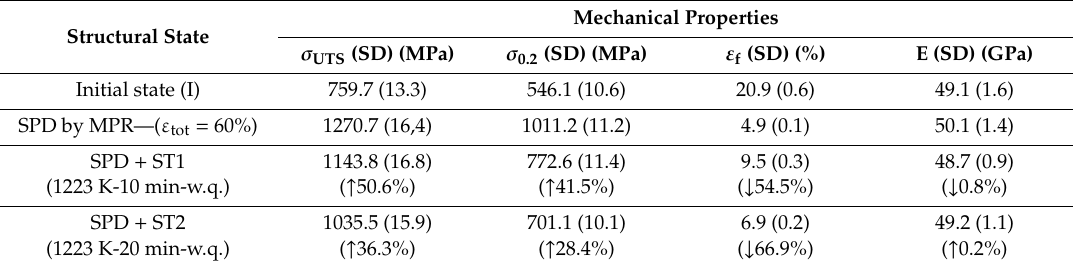
Figure 13. The stress–strain curve of the samples processed by the 2nd direction of the TMP program: SPD-MPR ( ε tot = 60%) + ST1 (1223 K-10 min-WQ). Table 3. Mechanical properties of the studied alloy at the end of the 2nd direction of experiments: Ultimate Tensile Strength ( σ UTS ); Yield Strength ( σ 0.2 ); Elongation to Fracture ( ε f ); Elastic Modulus (E); SD (Standard